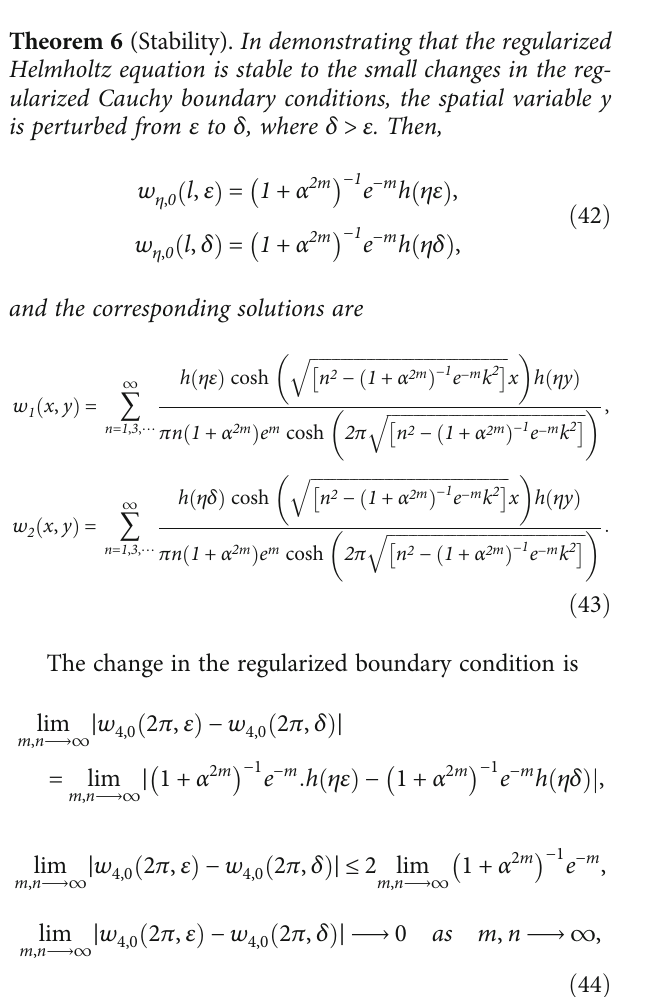
ffiffiffiffiffiffiffiffiffiffiffiffiffiffiffiffiffiffiffiffiffiffiffiffiffiffiffiffiffiffiffi n 2 − 1+ α 2 m ð ffiffiffiffiffiffiffiffiffiffiffiffiffiffiffiffiffiffiffiffiffiffiffiffiffiffiffiffiffiffiffi n 2 − 1+ α 2 m e 2 π